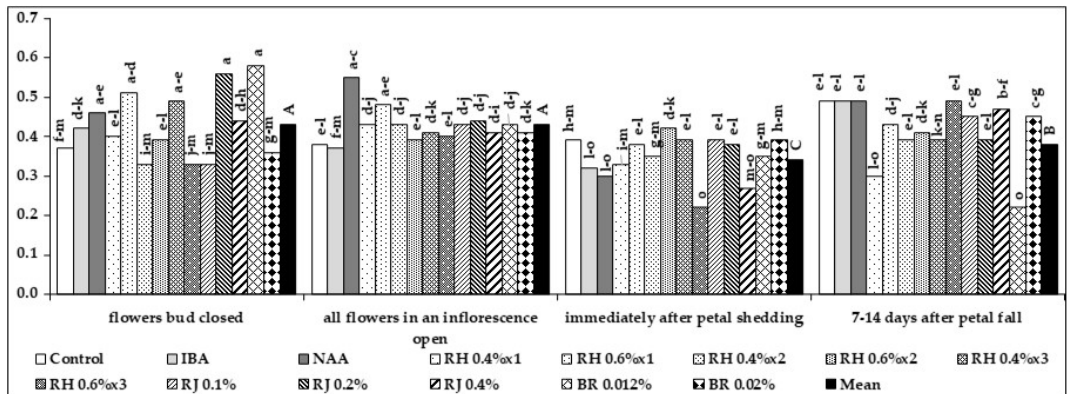
Figure 10. The influence of rooting enhancers on carotenoids content (mg g − 1 FW) in leaves of Rosa ‘Maiden’s Blush’ cuttings harvested from shoots in four phenological stages of shoots. Control—the control cuttings; IBA 0.4%—Ukorzeniacz A aqua (0.4% IBA); NAA 0.2%—Ukorzeniacz B aqua (0.2% NAA); RH 0.4%×1, RH 0.6%×1—watering with 0.4% or 0.6% Bio Rhizotonic (10 mL) after planting; RH 0.4%×2, RH 0.6%×2—watering with 0.4% or 0.6% Bio Rhizotonic (10 mL) after planting and 10 days later; RH 0.4%×3, RH 0.6%×3—watering with 0.6% Bio Rhizotonic (10 mL) after planting, 10 and 20 days later; RJ 0.1%, RJ 0.2%, RJ 0.4%—watering with 0.1%, 0.2%, or 0.4% Root Juice™ (10 mL) after planting; BR 0.012%, BR 0.02%—watering with 0.012% or 0.02% Bio Roots (10 mL) after planting. Different small letters indicate significant interactions between phenological stage and treatment (two-way ANOVA). Different capital letters indicate significant differences between phenological stages. The Duncan’s test ( α = 0.05) was used.